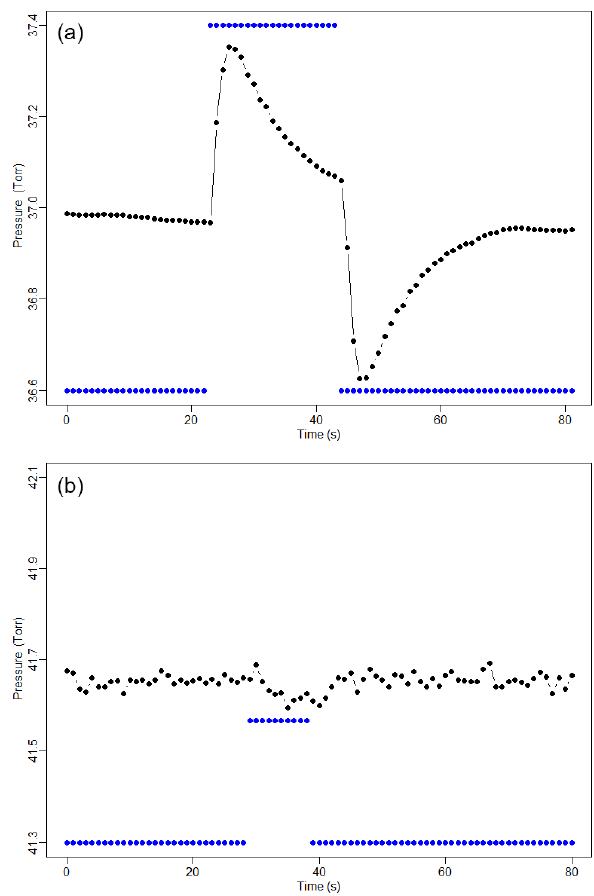
Figure 2. Cell pressure (black) in response to actuating a solenoid and sampling a standard cylinder (blue indicates solenoid position). The pressure control setup (a) , including excess flow, exhibits sig- nificant pressure perturbations and residual transients that persist longer than the desired calibration time. The mass flow control setup (b) shows pressure perturbations of shorter duration and on the or- der of 0.04Torr, 20 times smaller than with pressure